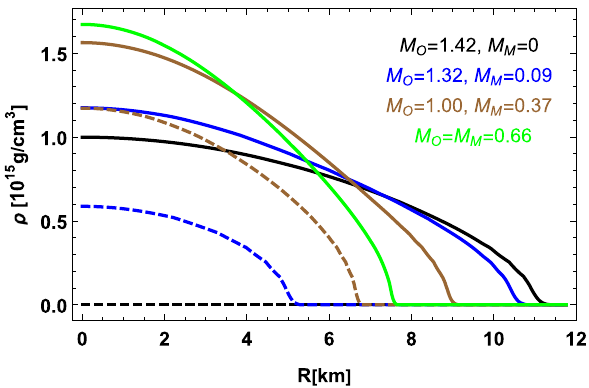
Fig. 1 Density profiles ρ O ( r ) (solid) and ρ M ( r ) (dashed) in a star with the initial mass M O (cid:17) 1 . 42 M (cid:16) at different stages of its evolution from χ = 0 (black) to χ = 1 (green) with intermediate values χ = 0 . 5 and 0 . 75 (respectively, blue and brown). The corresponding total masses of the ordinary and mirror spheres, respectively M O and M M , are given in the legend (in solar mass units M (cid:16) ). Computations are performed using the Sly EoS